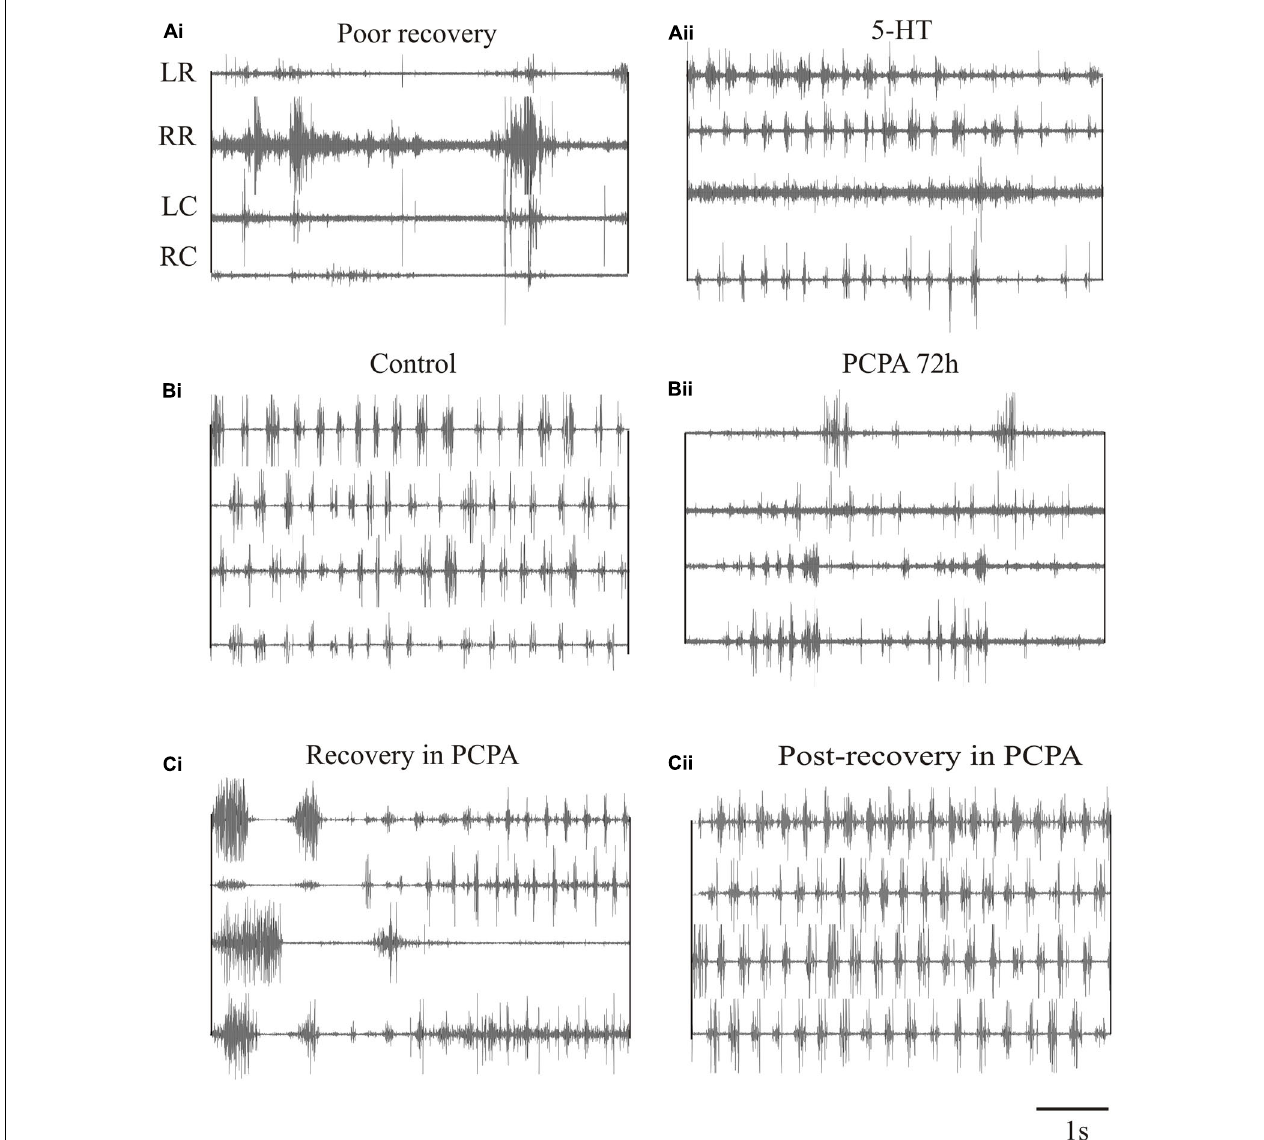
FIGURE 9 | Effects of 5-HT on swimming. (Ai,Aii) EMG traces from swimming animals showing activity above and below the lesion site in an animal that failed to recover locomotor function, and the effects of 5-HT in improving activity in the same animal. (Bi,Bii) EMG traces showing activity in an unlesioned animal, and in the same animal after incubation in PCPA for 72 h to deplete 5-HT. (Ci) EMG traces showing the poor activity in an animal that was incubated in PCPA after lesioning. (Cii) EMG traces showing activity in a lesioned animal after incubation in PCPA after it had recovered. Note that after recovery incubation in PCPA was without effect. Data from Becker and Parker (2015). No permission is required to reproduce this